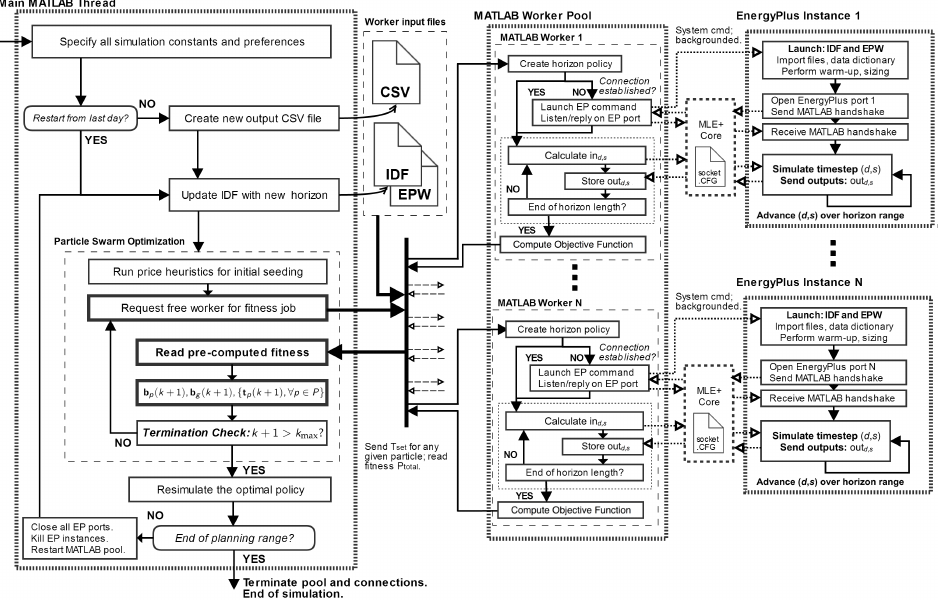
Figure 1. An overview of the optimizer architecture, which utilizes a co-simulation between Matlab and EnergyPlus. CSV: logs of setpoints and results in comma-separated values format; IDF: building and simulation description in EnergyPlus input data file format; EPW: hourly weather data in EnergyPlus weather file